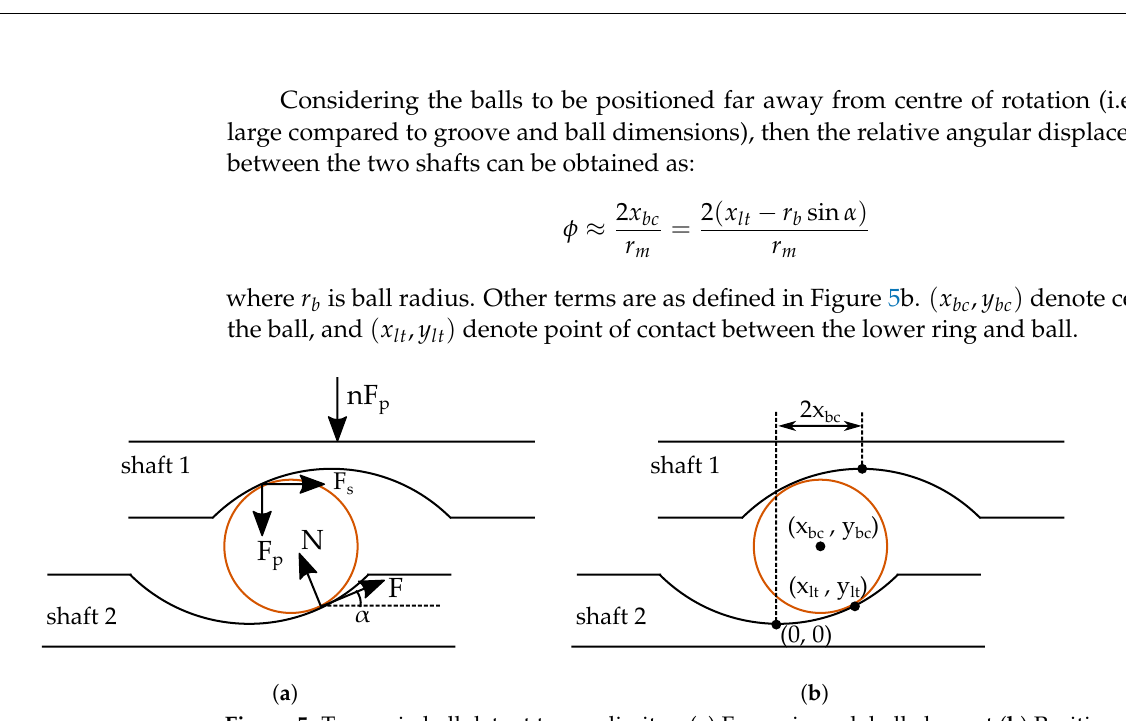
Figure 5. Torque in ball detent torque limiter: ( a ) Forces in each ball element ( b ) Position of differ- ent elements.